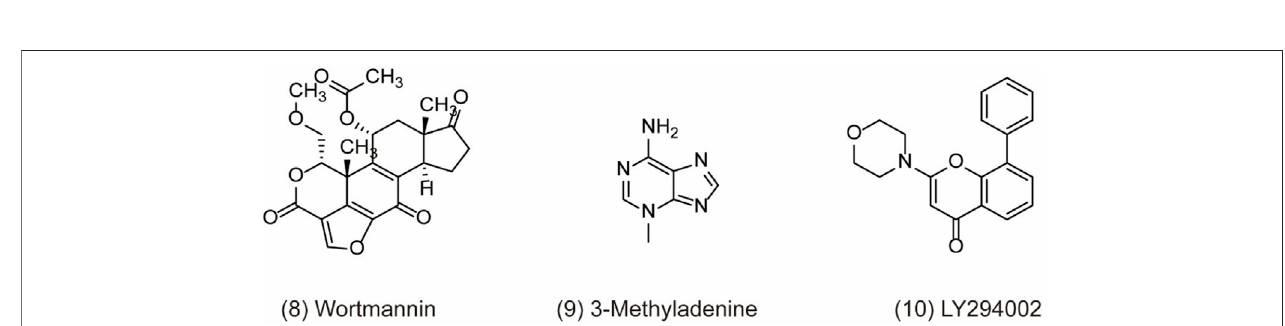
FIGURE 3 | Chemical structures of 8 – 10 as inhibitors of autophagy by targeting PI3K-III.